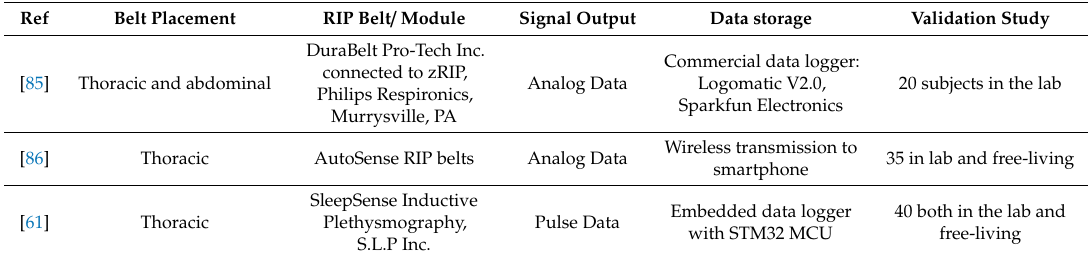
Table 9. A summary of wearable Respiratory Inductance Plethysmography (RIP) sensors employed in smoking research.